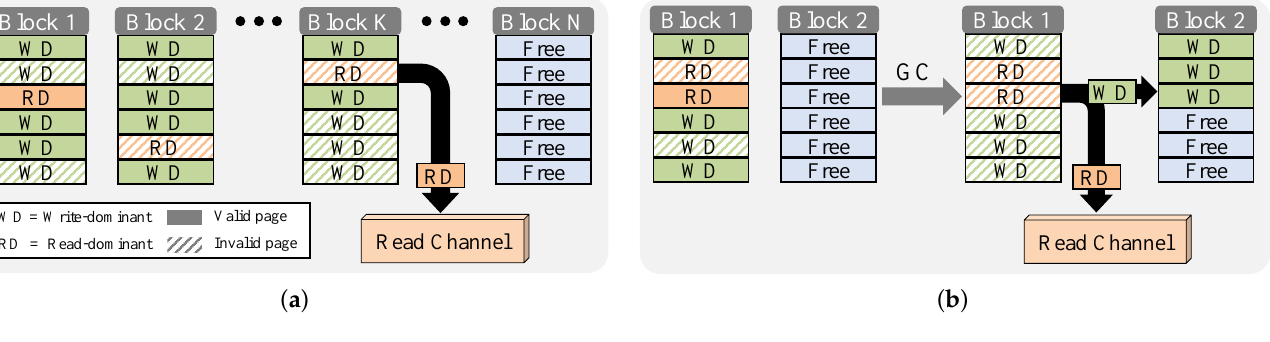
Figure 5. Procedure for read-dominant pages migration vulnerable to R/W interference: ( a ) GC- aware migration at idle time; ( b ) GC-piggybacked migration during GC